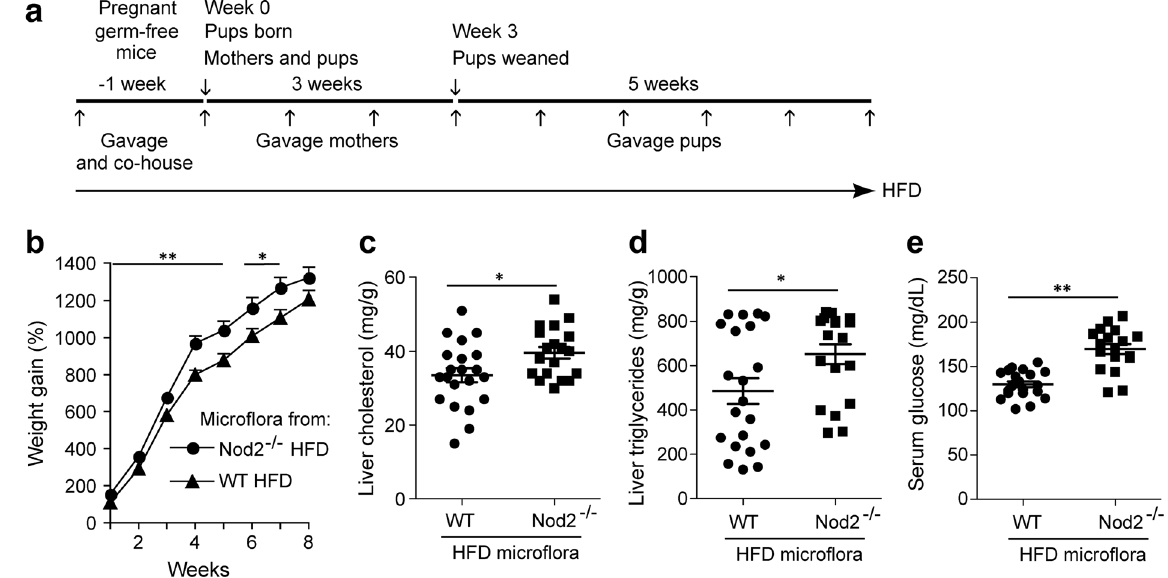
Figure 7. Intestinal microbiota from Nod2 − / − mice on HFD increases susceptibility of germ-free mice to HFD-induced obesity and metabolic dysfunction. ( a ) One week before delivery, we colonized germ-free WT Swiss Webster female pregnant mice, kept under sterile conditions, with microbiota from WT or Nod2 − / − mice maintained on HFD. Colonization was done by both gavaging with fecal microbiota and by co-housing. Gavaging was done into the stomach with fecal homogenates from WT or Nod2 − / − mice maintained on HFD (indicated by ↑ ). At the same time, the gavaged mice were placed on HFD and also co-housed with Nod2 − / − or WT female mice that had been maintained on HFD for ~20 weeks. The co-housed Nod2 − / − HFD and WT HFD mice were removed when the pups were born (week 0). Mothers and pups were maintained on HFD for the length of the experiment. ( b – e ) Pups were monitored for ( b ) gain in weight every week and after 8 weeks assayed for ( c ) liver cholesterol, ( d ) liver triglycerides and ( e ) serum glucose. ( b ) Results are means ± SEM and ( c – e ) individual data of 19–21 mice/group. * P ≤ 0.05 and ** P ≤ 0.001, Nod2 − / − Abx + HFD versus Nod2 − / −